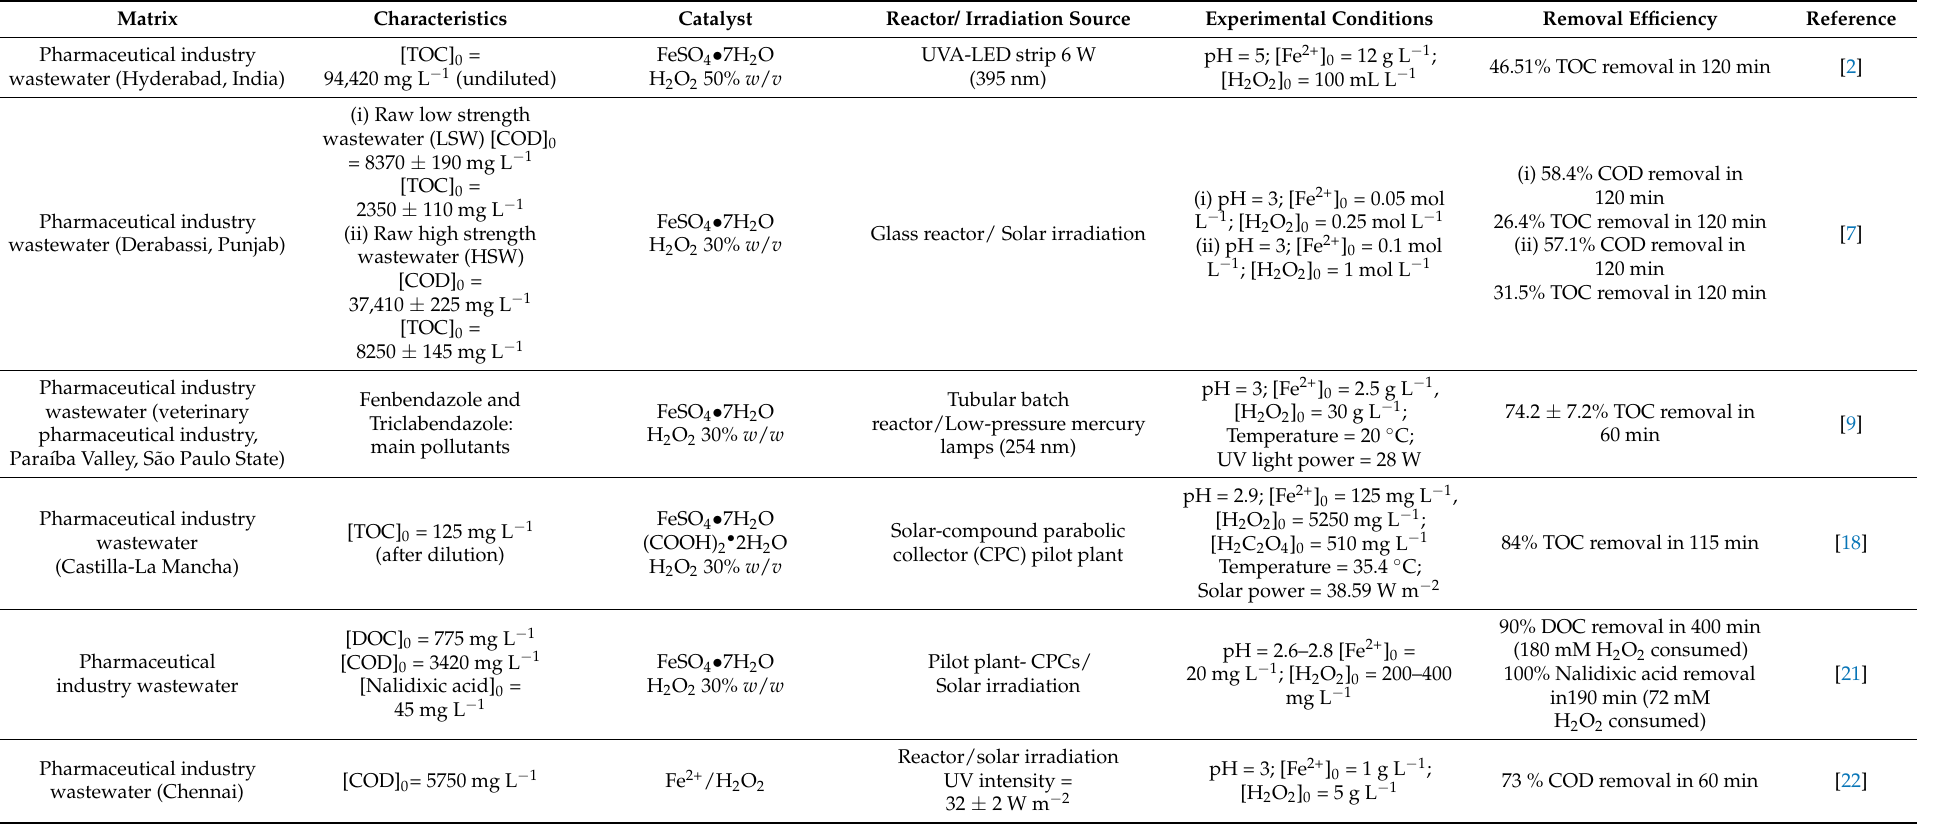
Table 3. Photo-Fenton and photo-Fenton-assisted processes for the treatment of pharmaceutical industry